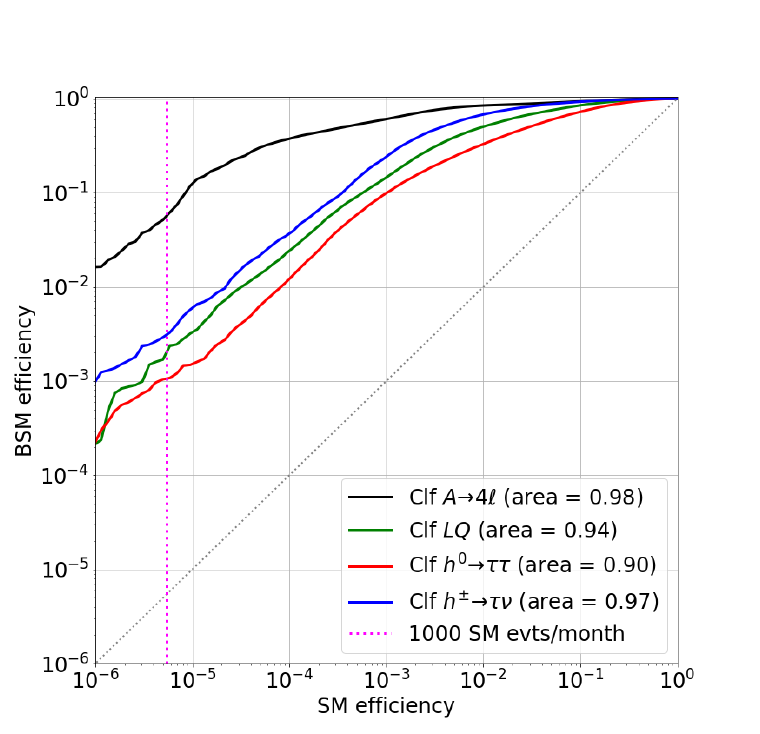
Figure 6 . ROC curves for the fully-supervised BDT classi(cid:12)ers, optimized to separate each of the four BSM benchmark models from the SM cocktail